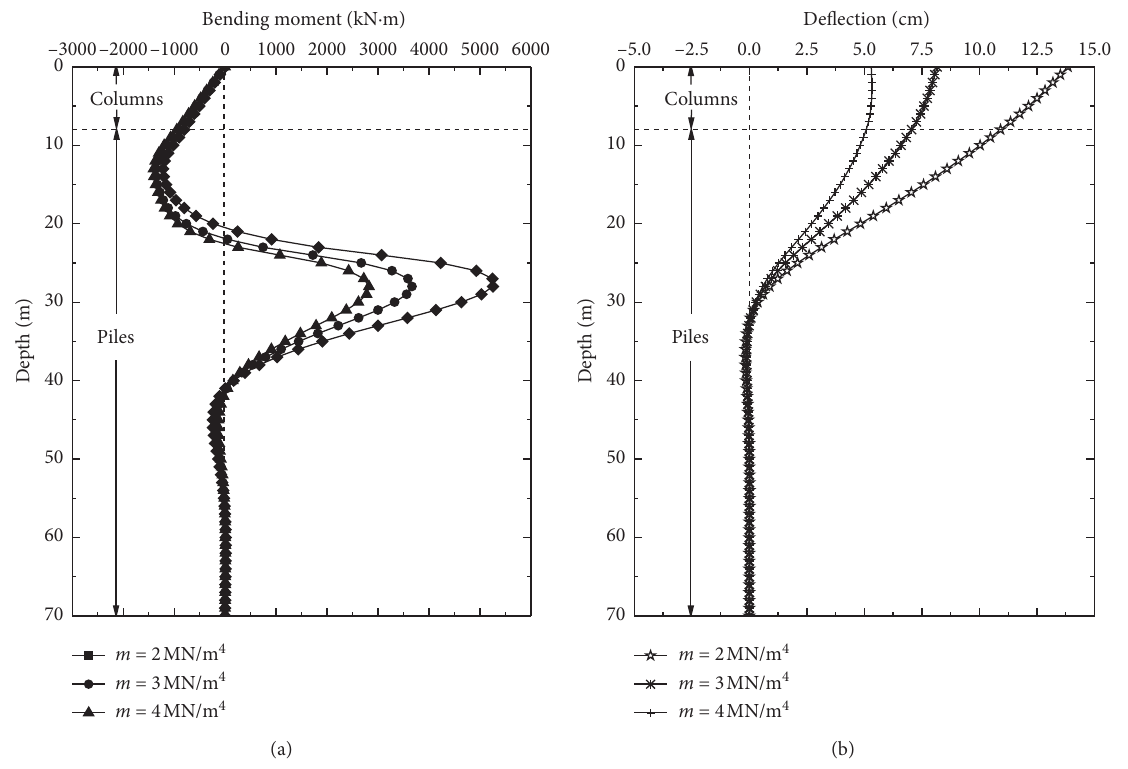
Figure 12: Effect of soil resistance on the piles-columns response. (a) Bending moment. (b)